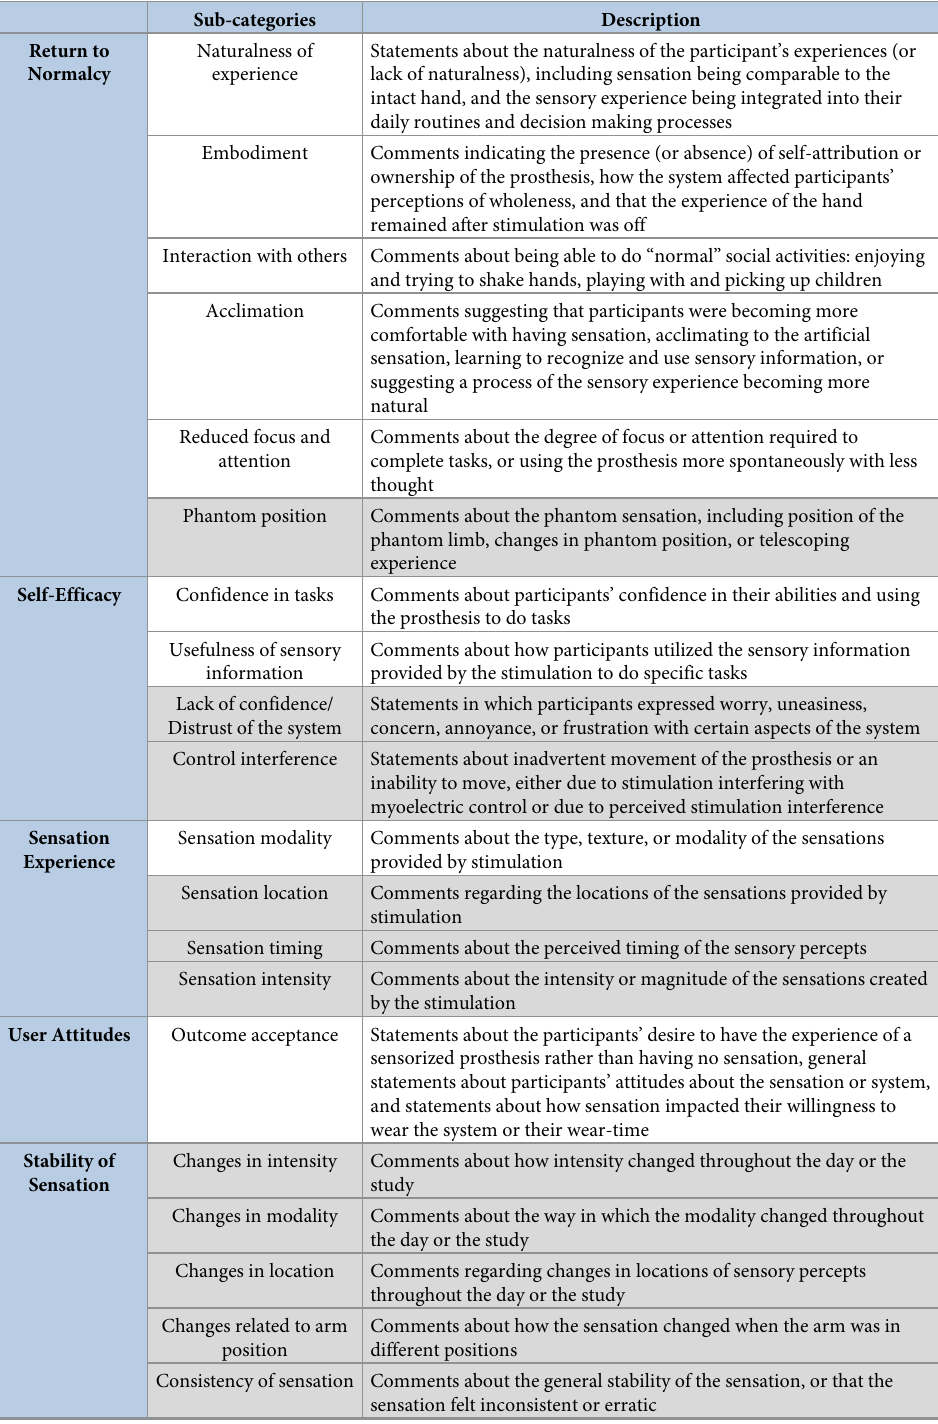
Table 1. Coding structure. Left column indicates category, middle column indicates sub-category, and right column describes the content coded within each sub-category. White rows were included in the model; grey rows were